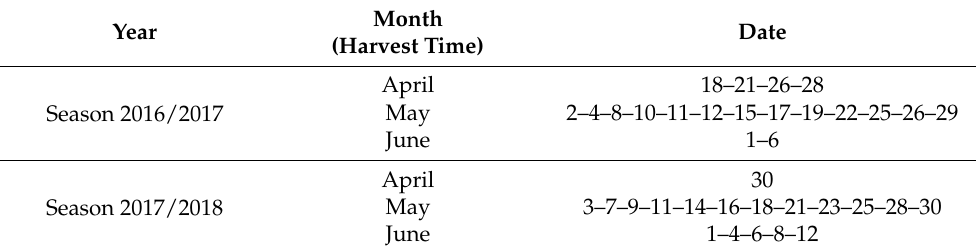
Table 4. Harvesting dates for 2016/2017 and 2017/2018